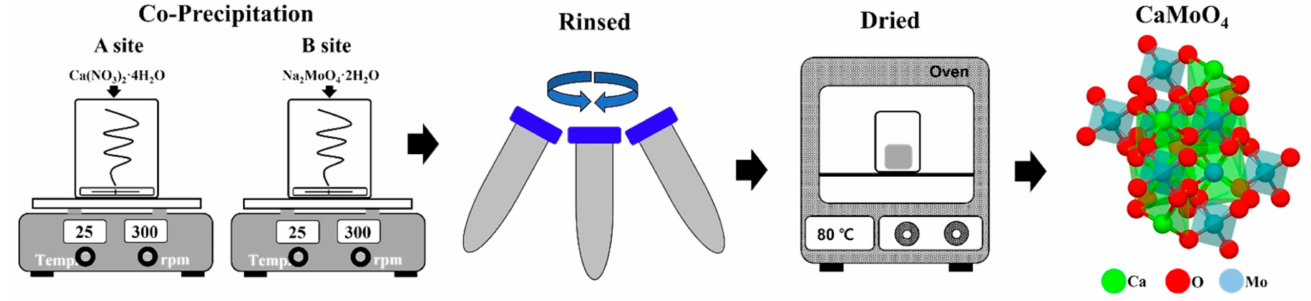
Figure 1. Schematic of the SrMoO 4 synthesis procedure via co-precipitation at room